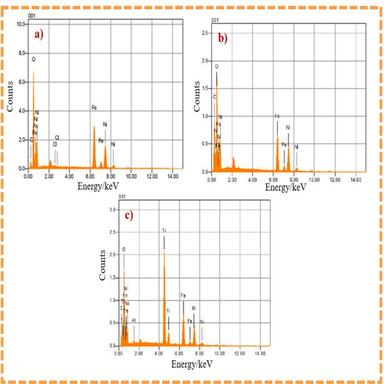
EDX spectra of (a) NF-ldh (b) NF-ldh/gCN (c) NF-ldh/MXene.